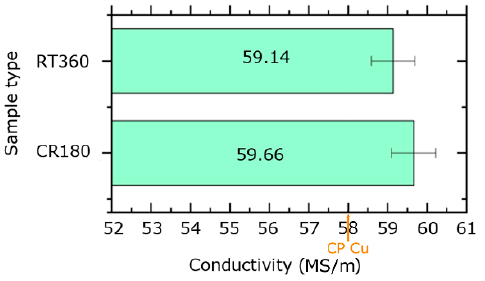
Figure 4. Depiction of experimentally measured electric conductivity for RT360 and CR180 specimens with comparison to CP Cu.